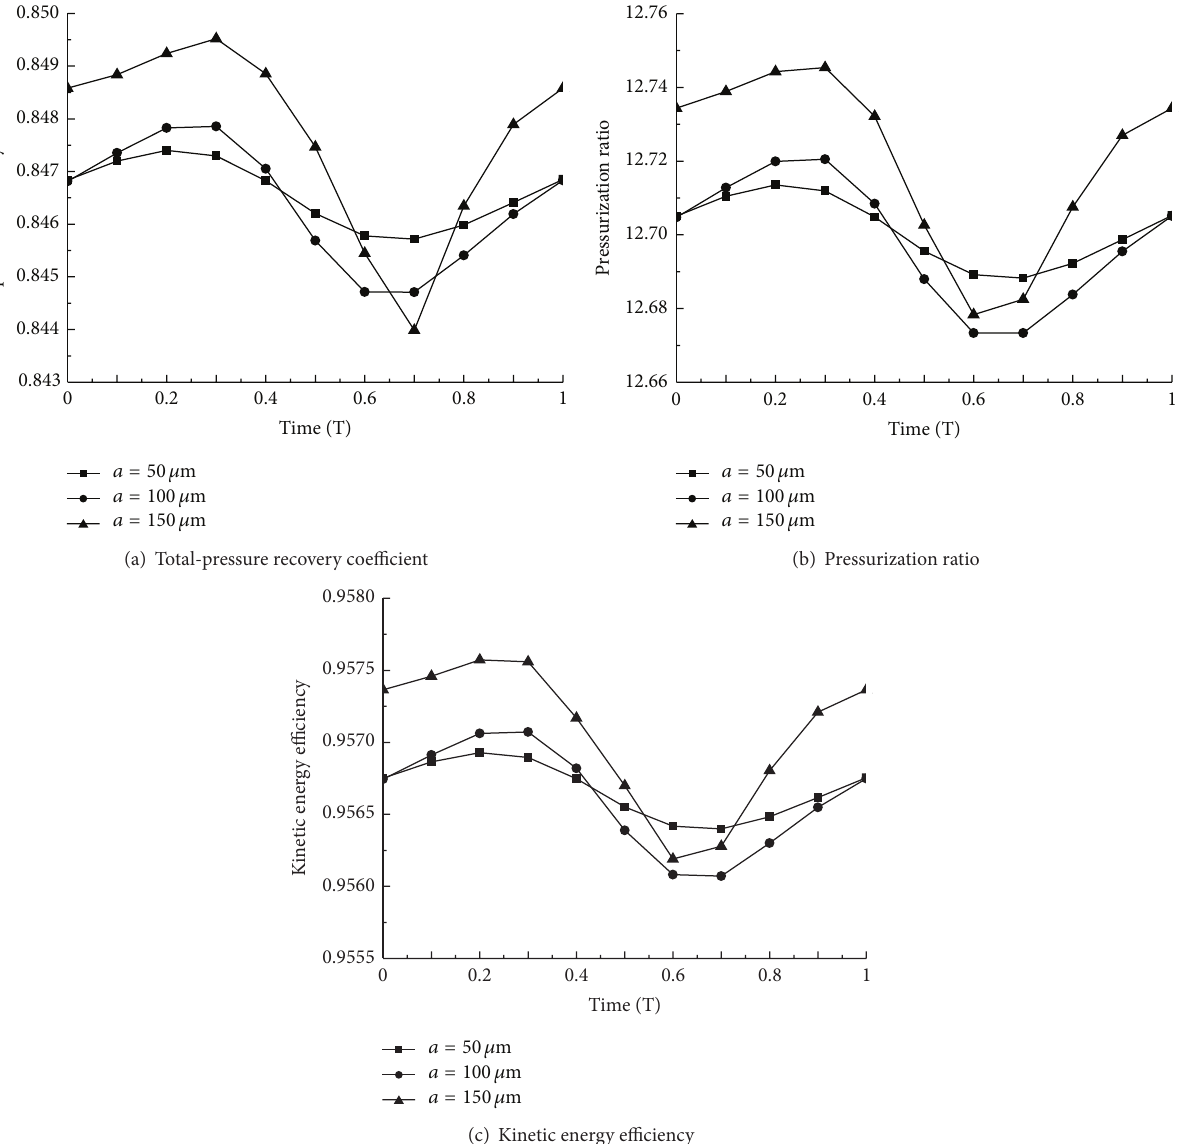
Figure 21: Flow performance in different rotor whirling amplitudes during a whirling motion cycle.